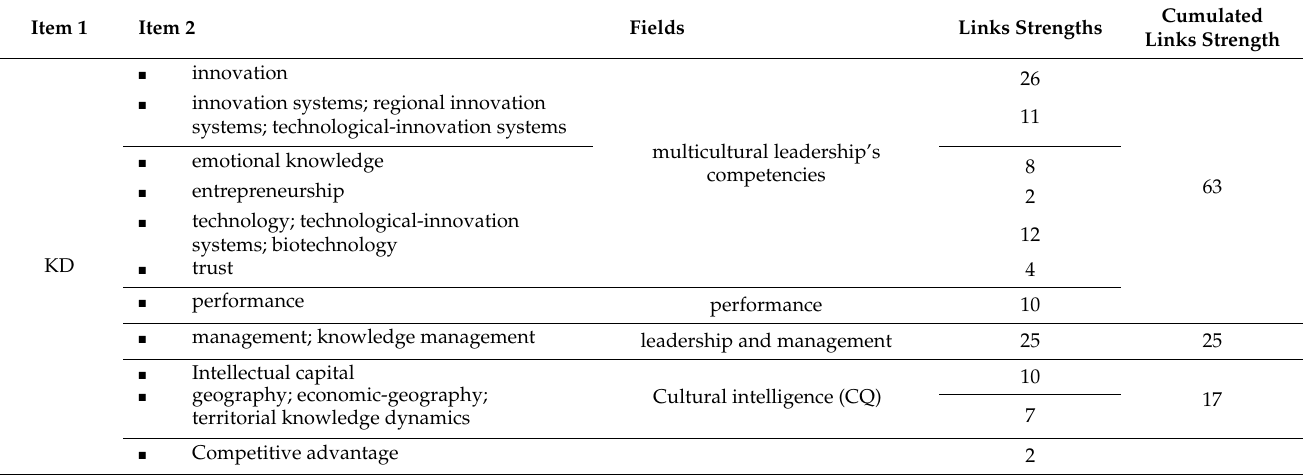
Figure 2. KD: Keyword’s co-occurrence network-related publications—by VOSviewer (92 items meeting threshold of 5 occurrences of keywords) (Source: authors’ own research). Table 6. Keyword’s co-occurrence network of KD-related publications/Direct links to KD—by VOSviewer (Source: authors’ own